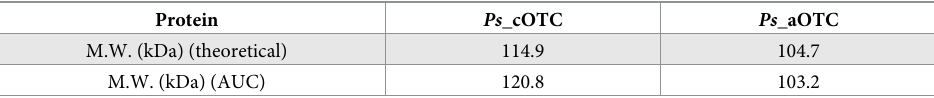
Table 1. Molecular weight (M) of Ps _cOTC and Ps _aOTC determined by analytical ultracentrifugation (AUC).